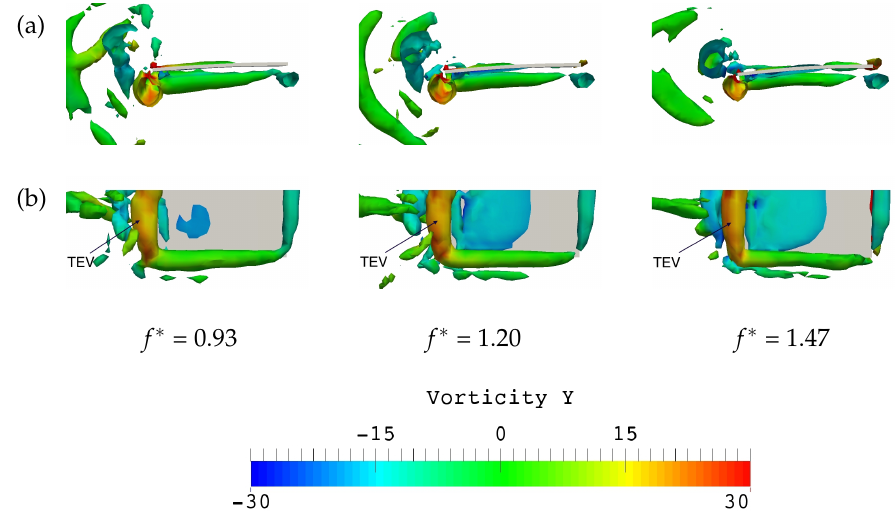
Figure 14. ( a ) Front view and ( b ) bottom view of three-dimensional vortex structures at the phase instant when a peak value of thrust appears for the cases of; f ∗ = 0.93, f ∗ = 1.20 and f ∗ =